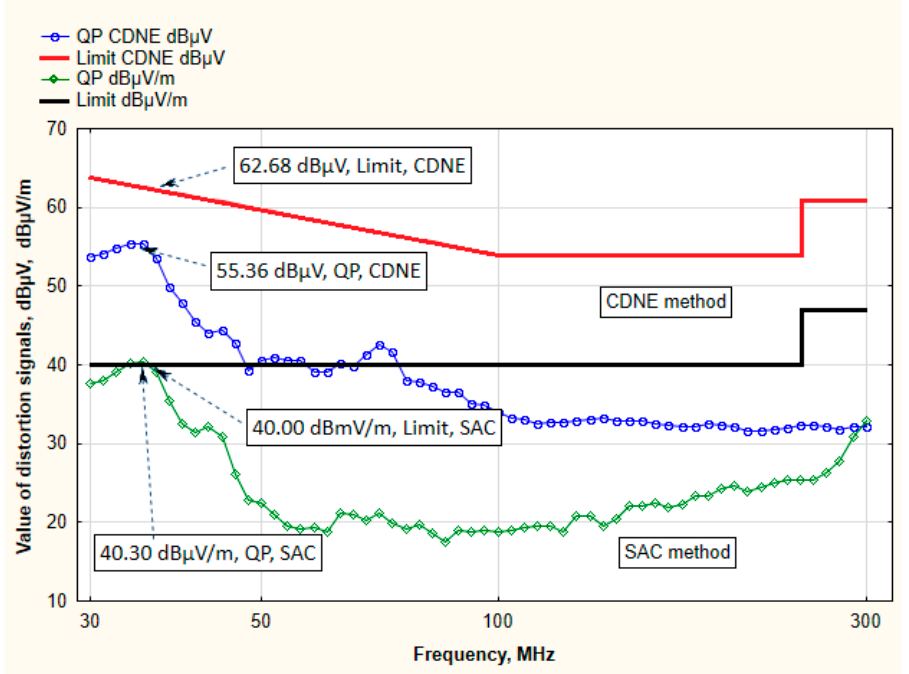
Figure 9. Recorded QP values using the new and traditional method against the allowable limits for the tested LED lamp B.